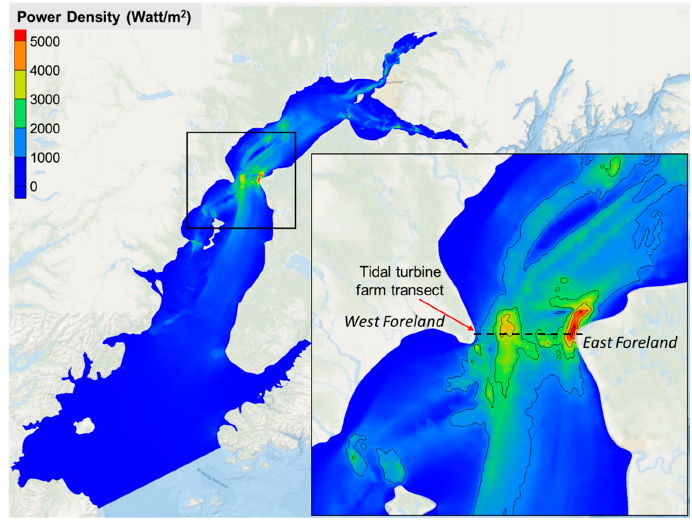
Figure 12. Two-dimensional distribution of time- and depth-averaged tidal power density inside Cook Inlet based on a three-month model simulation. The inset shows the zoom-in tidal power density distribution near the Foreland region. The dashed line indicates the location of the tidal turbine farm transect.